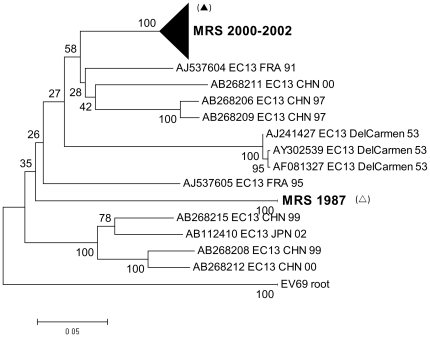
Phylogenetic tree of E13 isolates.All but two sequences were isolated between 2000 and 2002, and clustered in a distinct group. The greatest genetic distance was observed between #369 (clear triangle), isolated in 1987, and #375 (filled triangle), isolated in 2000.